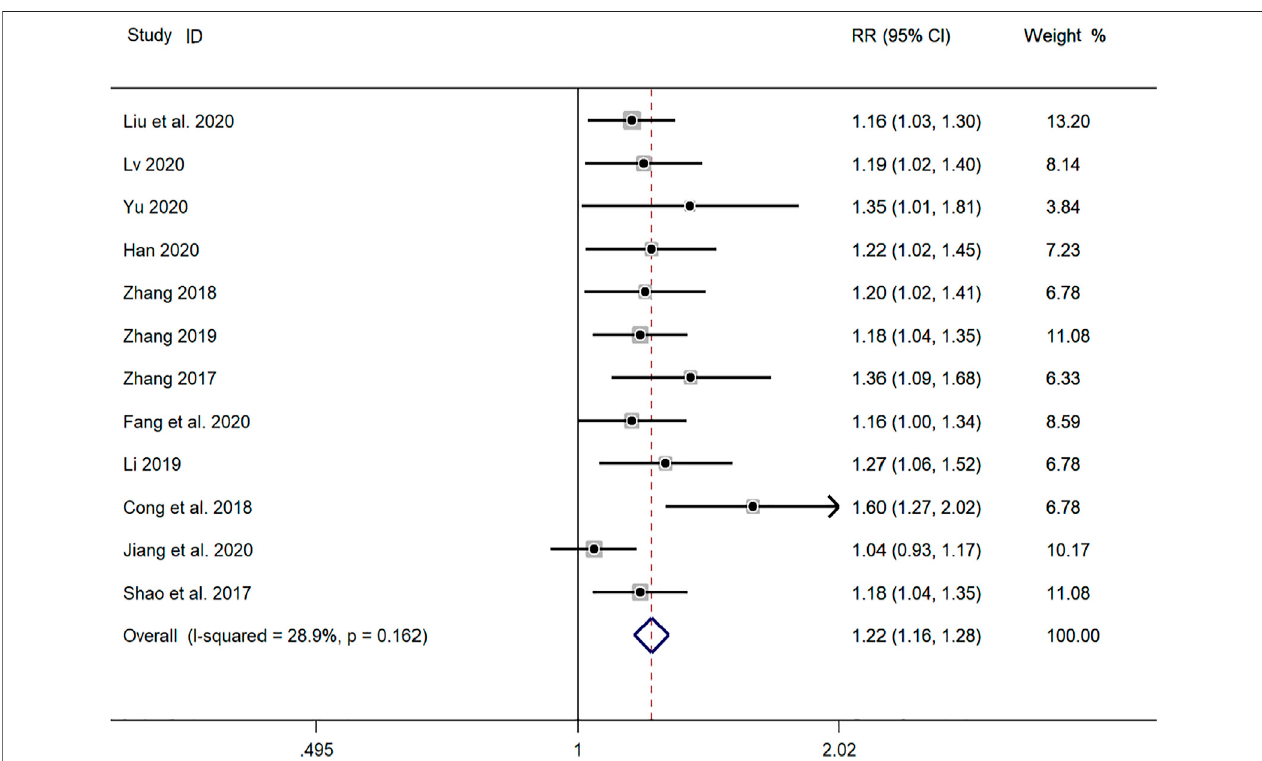
FIGURE 3 | Meta-analysis forest plot comparing the total ef fi ciency level of the experimental group and the control group.